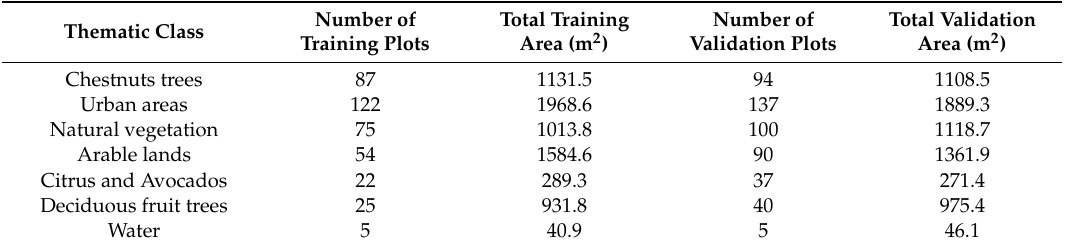
Table 1. Training and validation plots for the various thematic classes selected within the study